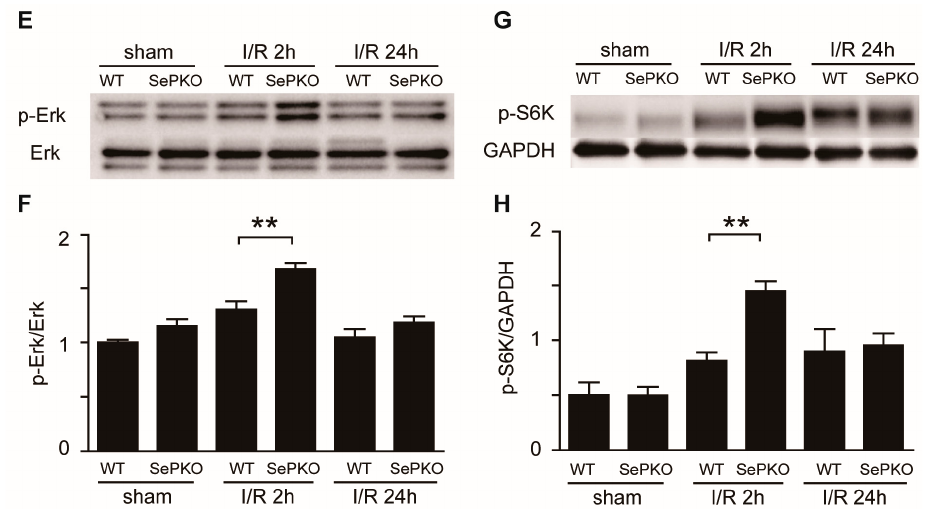
Figure 3. SeP gene deletion regulates the reperfusion injury salvage kinase. WT and SeP KO mice were subjected to 30 min of myocardial ischemia and 2 and 24 h of reperfusion. Representative Western blots of ( A ) phosphorylated-IGF1R and GAPDH, ( C ) phosphorylated-serine473-Akt and total Akt, ( E ) phosphorylated-Erk1/2 and total Erk1/2, and ( G ) phosphorylated-p70S6K and GAPDH.